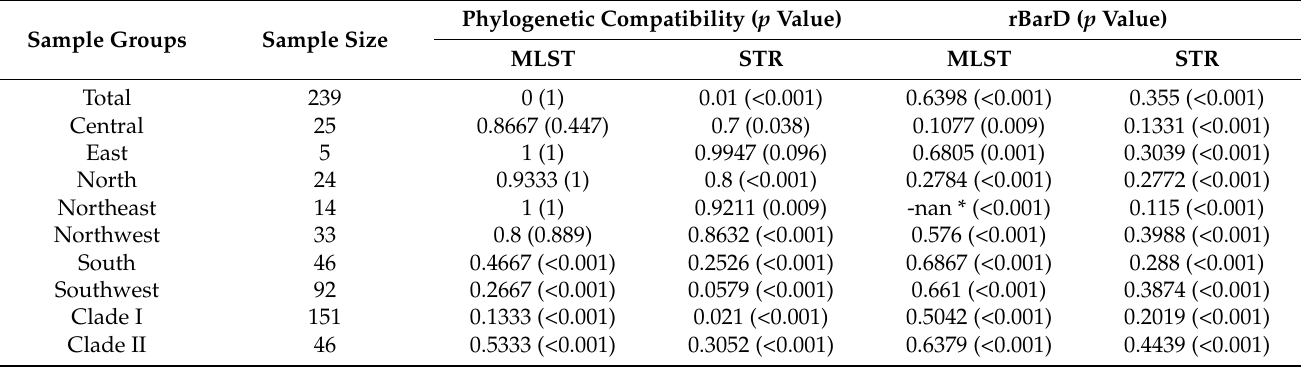
Table 4. Results of multilocus linkage disequilibrium analyses for different sample groups of A. oligospora from China. Sample